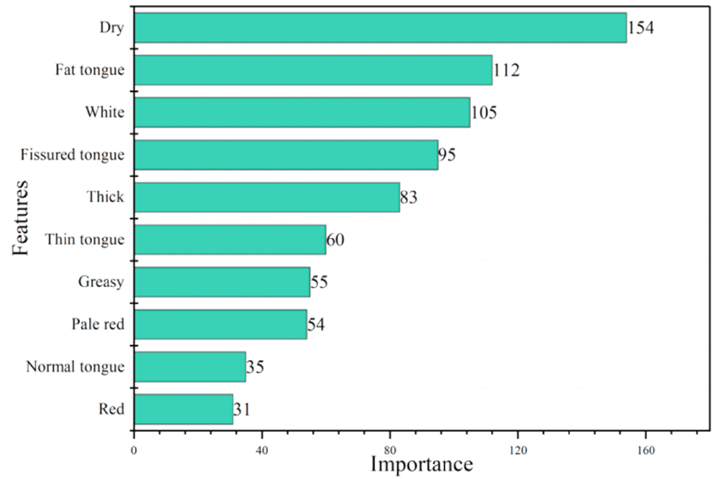
Figure 5. Importance of tongue features.